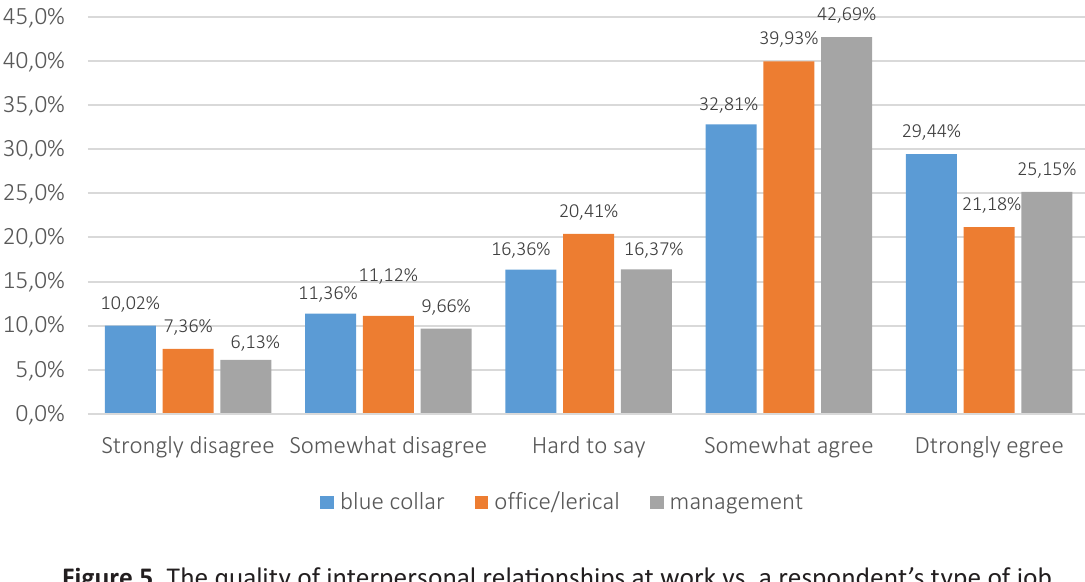
Figure 5. The quality of interpersonal relationships at work vs. a respondent’s type of